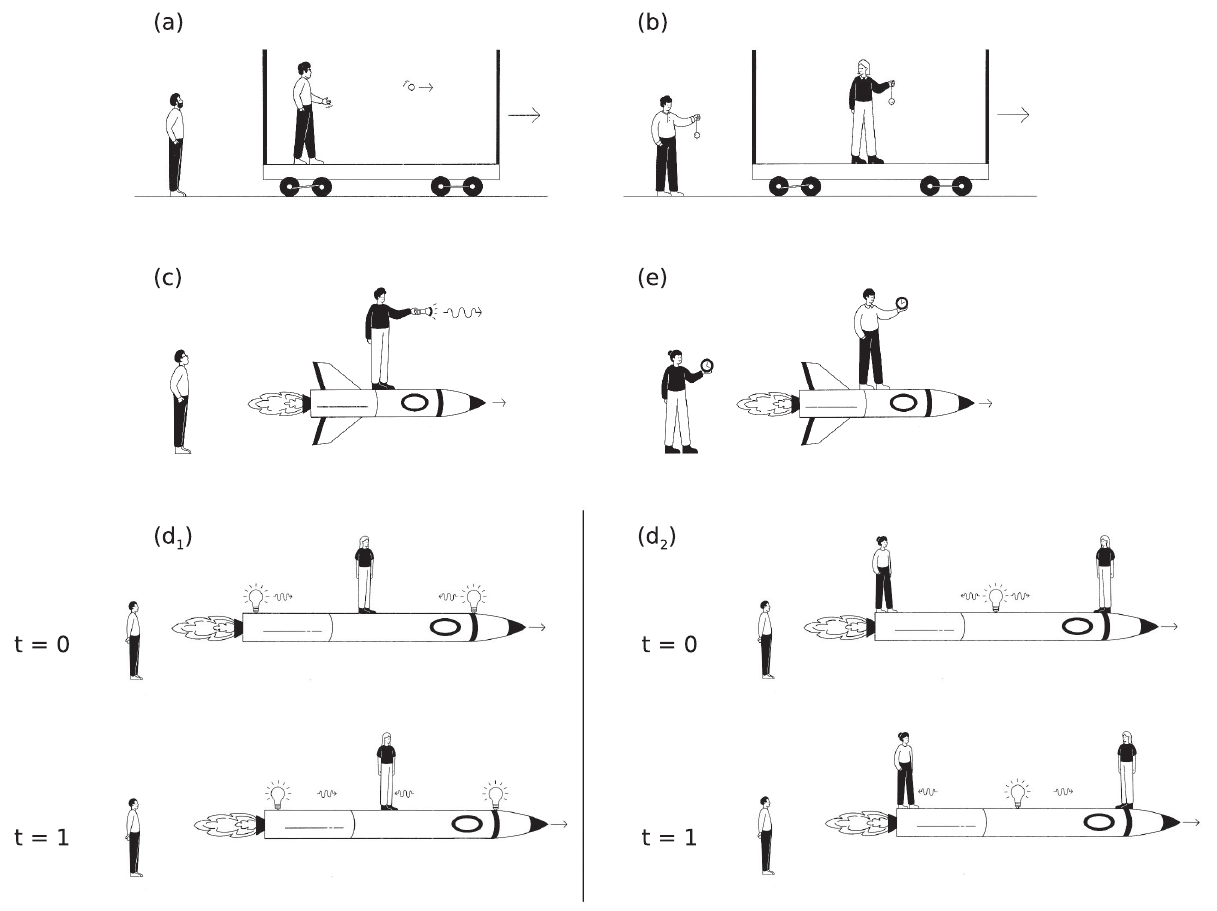
FIG. 3. Schematic illustrations of typical scenarios for TEs in the following categories: (a) Galilean transformation, (b) principle of relativity, (c) light postulate, ( d 1 ) and ( d 2 ) relativity of simultaneity, (e) time dilation, length contraction, and relativistic velocity addition. See the text for further explanation of the